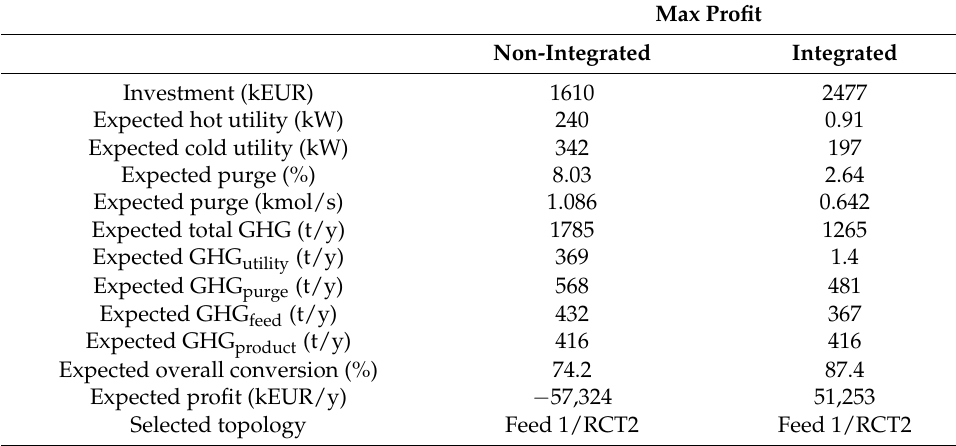
Table 5. Results of the multi-period process synthesis at different values of CO 2 emission tax.